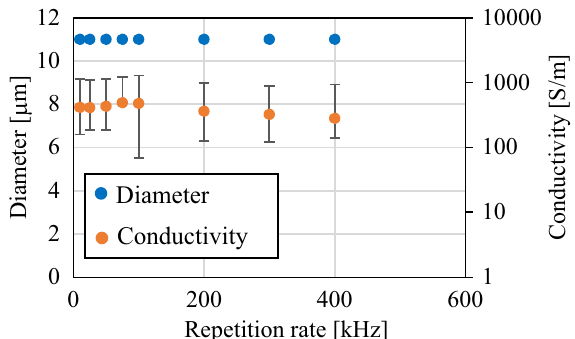
Figure 3. The relationship between pulse repetition rate and diameter and conductivity of wire-shaped modified region under several focus scanning rate.